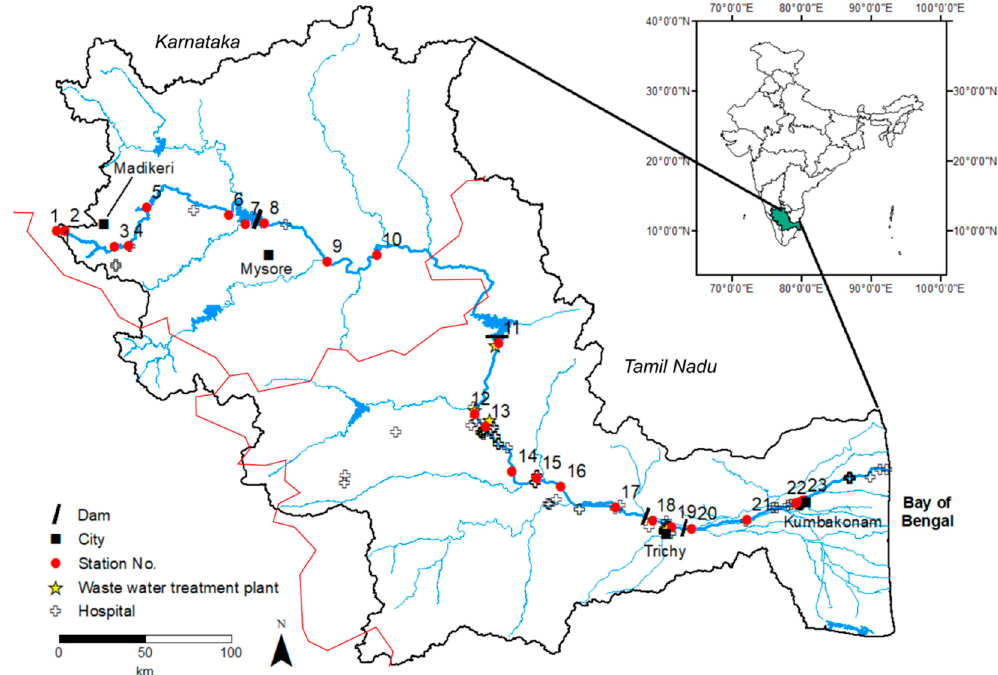
Figure 1. Map of study sites in Karnataka and Tamil Nadu, India, surface-water sampling locations (red circle), and station numbers along the river course. Station names are given in Table 1. Station 1 is the source; Station 23 at river delta. Pharmaceuticals were taken at the following stations only: 2, 9, 10, and 11. Only critical, large waste water treatment plant WWTPs are shown.